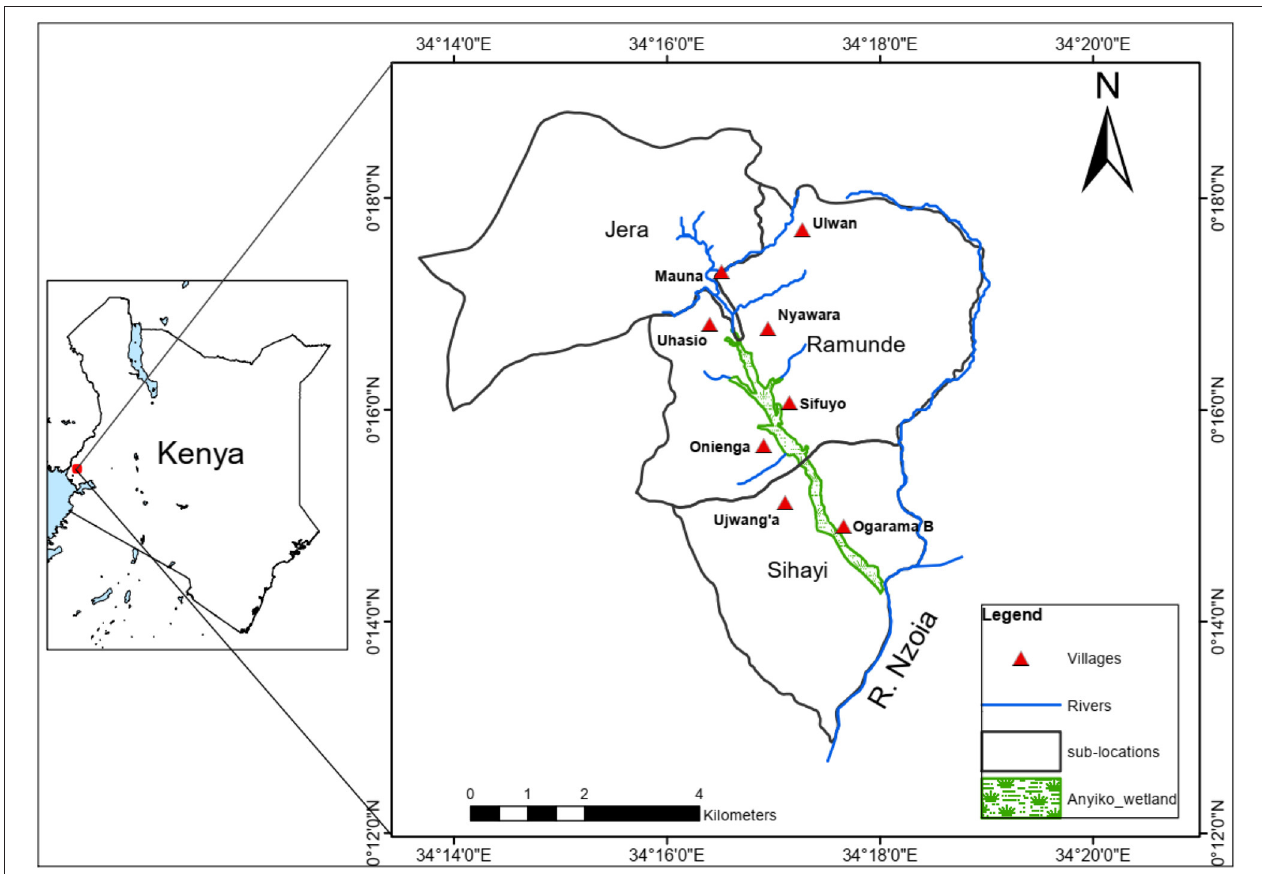
FIGURE 1 | Map showing location of the Anyiko wetland and the villages